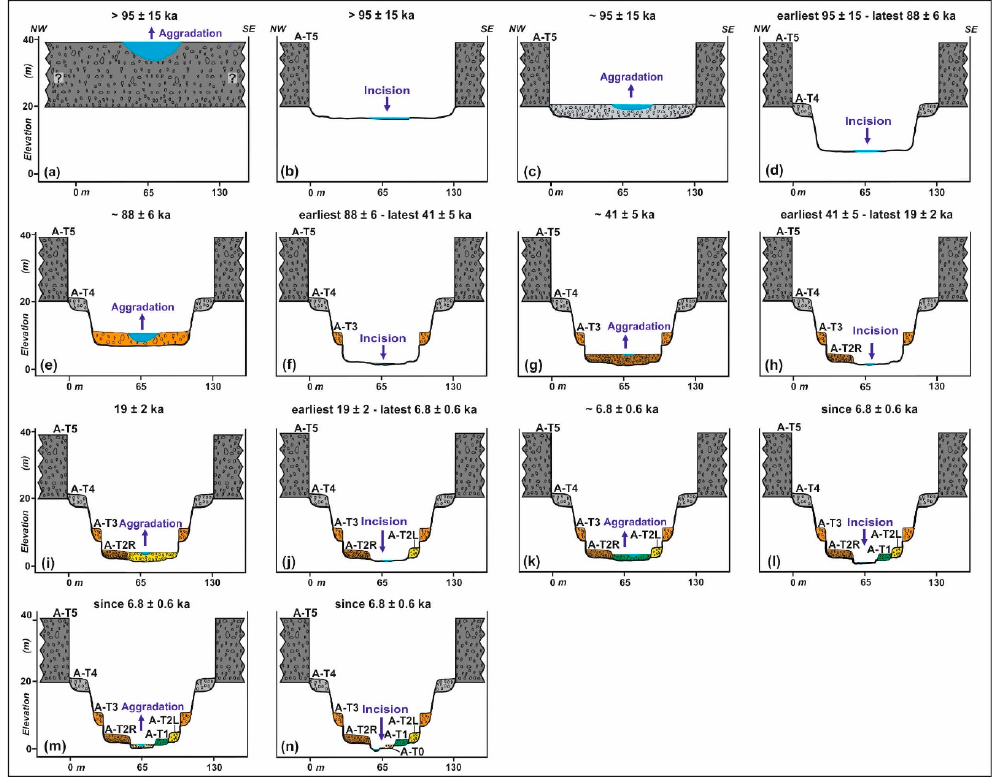
Figure 9. Schematic model of the landscape evolution at the apex of the present-day alluvial fan since